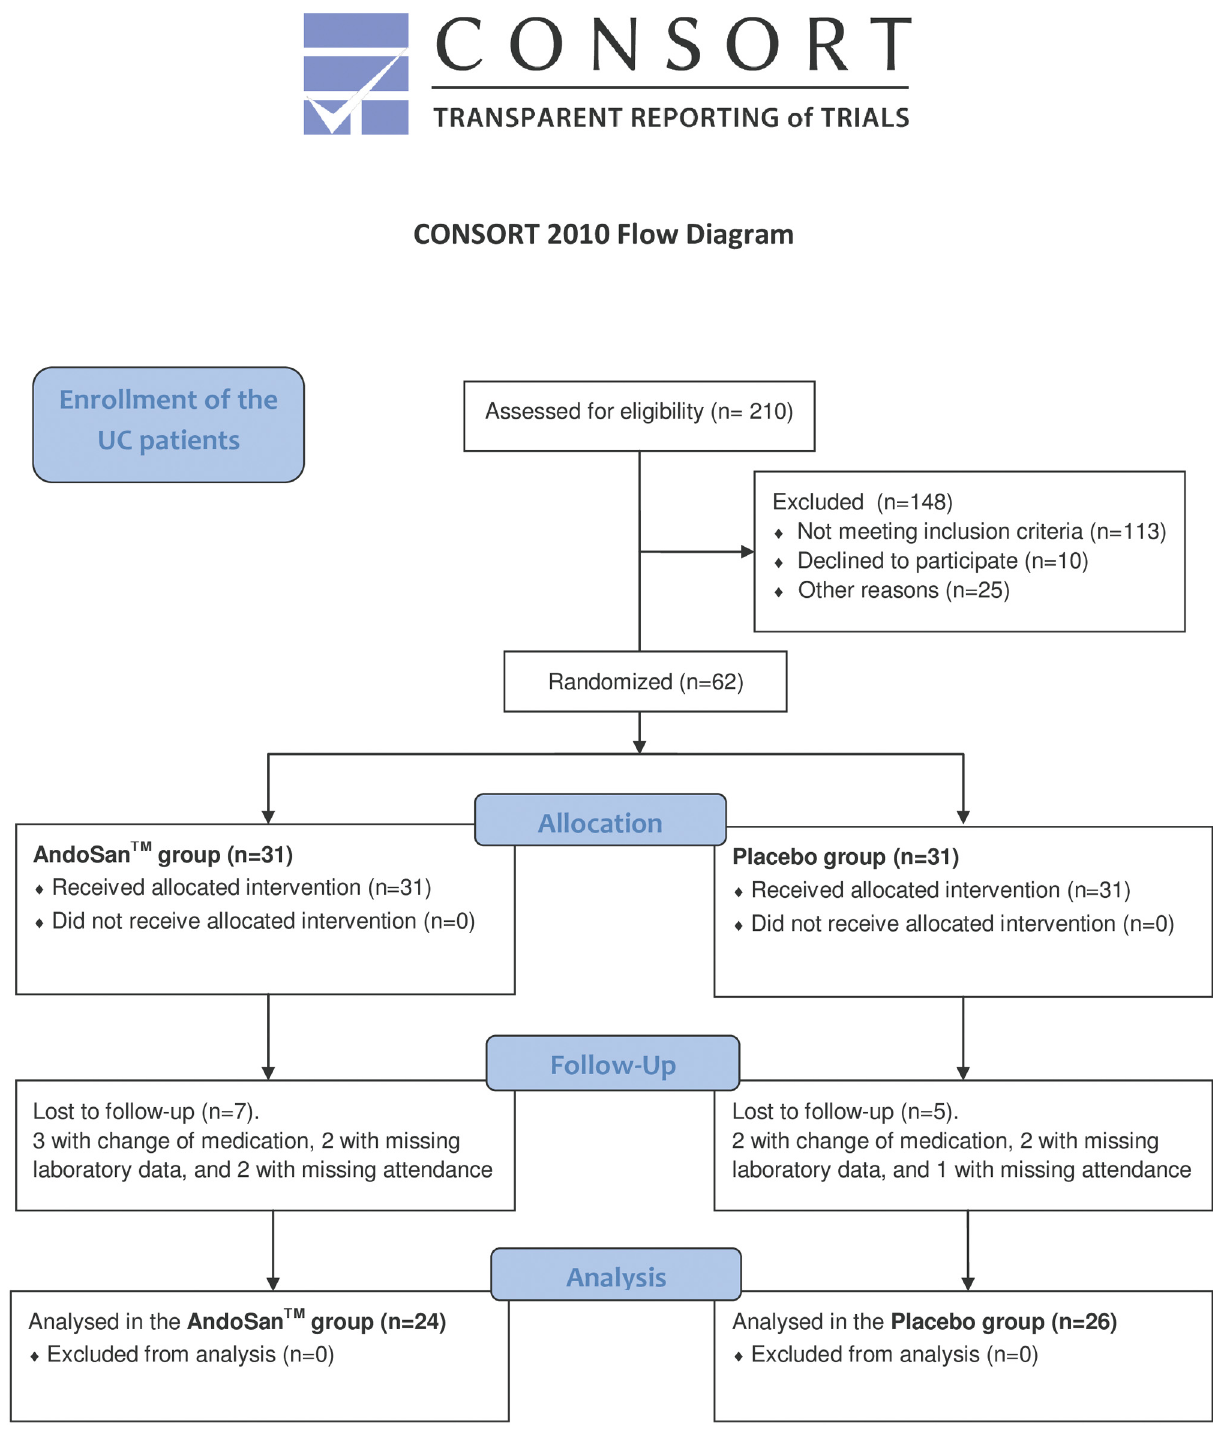
Fig 1. An algorithm showing the scheme for inclusion of the patients in the study.